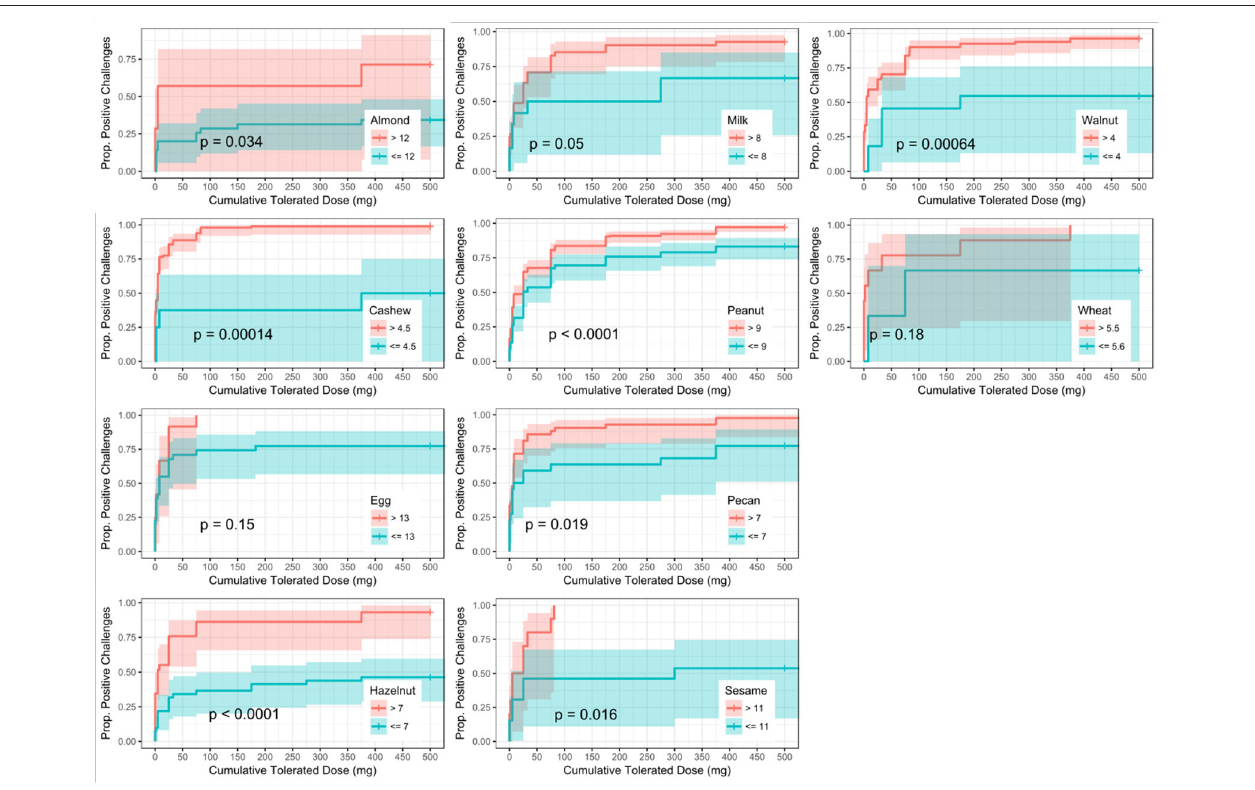
FIGURE 4 | Dose to positive challenge by skin prick test (SPT) threshold and food. Kaplan-Meier curves of dose to positive challenge stratified by the CTD-dependent ROC thresholds for SPT by food. Red lines indicate risk of a positive challenge if SPT is above the threshold, while blue lines indicate risk for participants with SPT at or below the